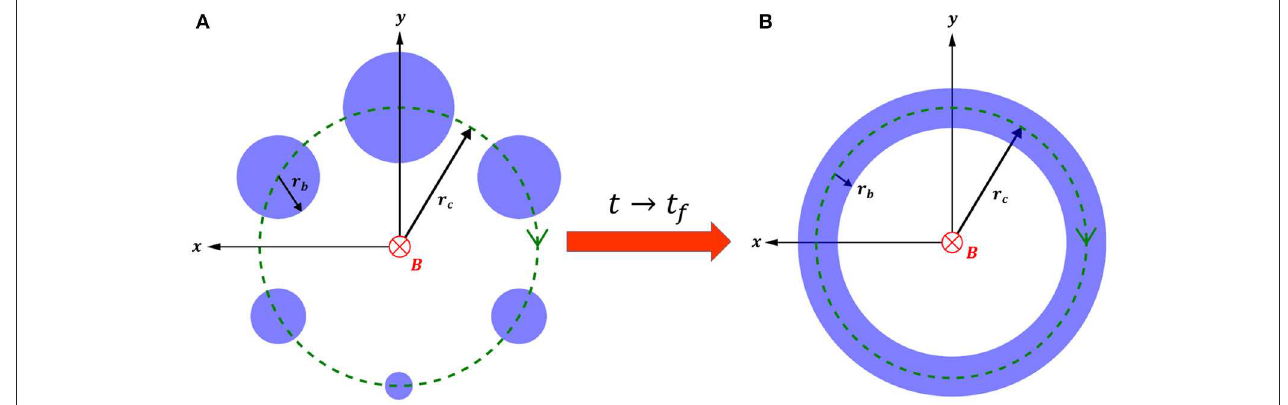
FIGURE 7 | Schematic of the beam cross-section density profile evolution, view from behind the beam looking along the field line. The beam centroid motion and envelope expansion and contraction are decoupled, but in phase, resulting in a cross section profile similar to that in (A) . As the beam approaches Earth, the spread in gyro-frequency evolves this profile into that of corkscrew, which is projected onto the atmosphere as a ring in (B) .